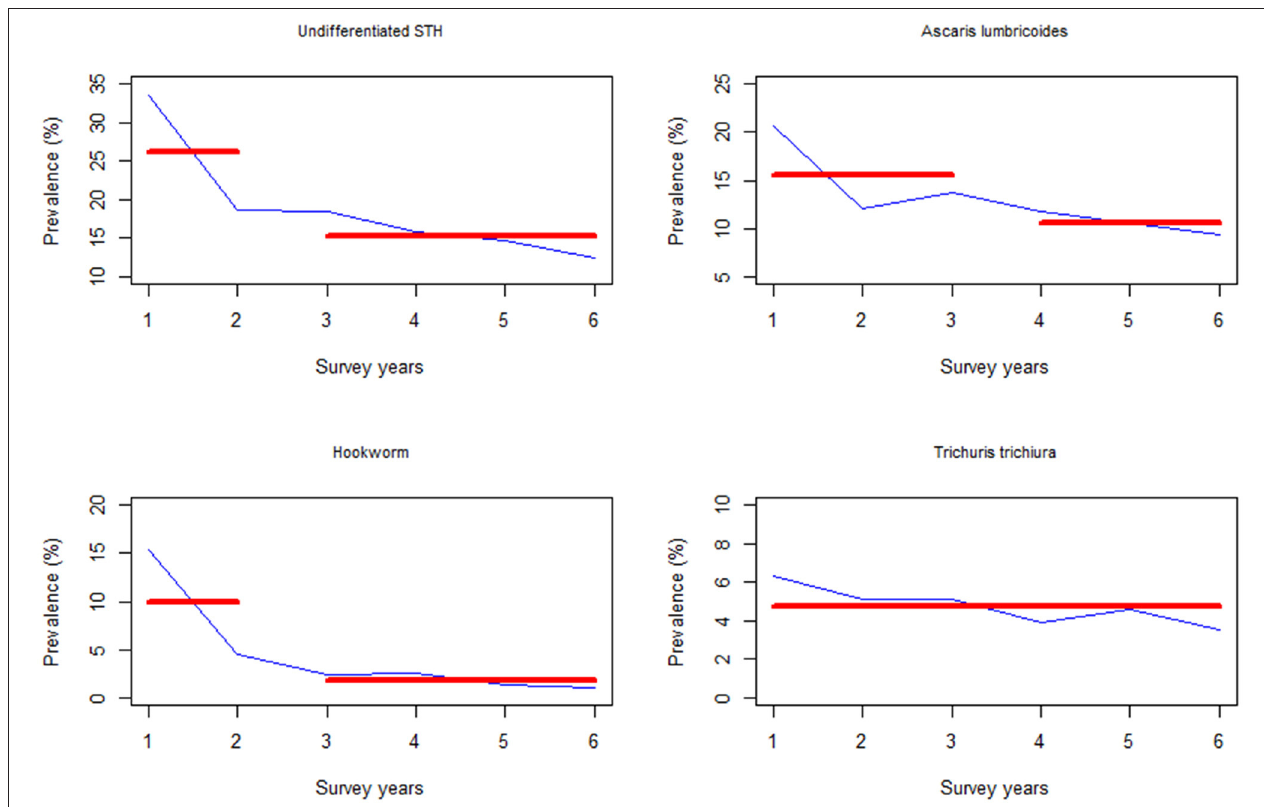
FIGURE 7 | Change point analysis using binary segmentation method for the pre-treatment prevalence (%) among the school aged (SAC) group of children in